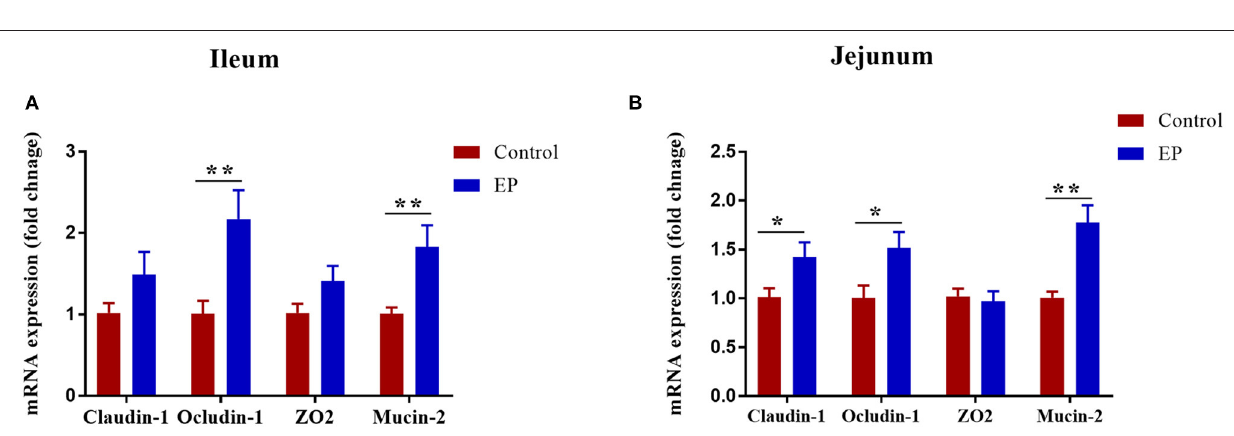
correlation analyses. The relationships of the altered gut microbiota and cecal SCFAs in response to EP treatment based on the Spearman correlation coefficients are shown in Figure 8